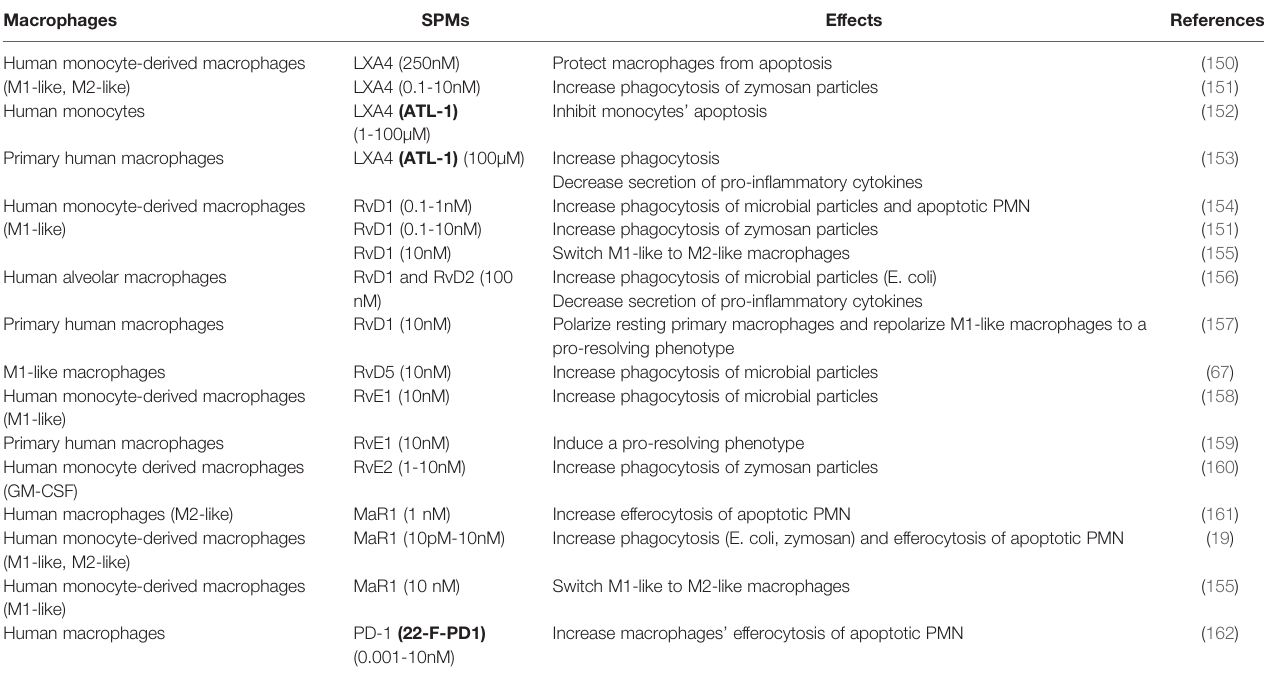
TABLE 1 | SPMs ’ in vitro effects on human macrophages in in fl ammatory